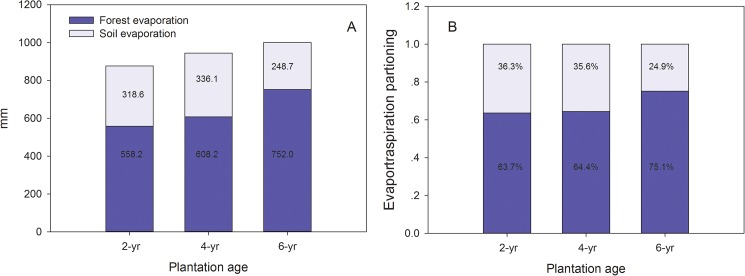
Absolute (A) and relative values (B) of evapotranspiration in different Eucalyptus plantations.